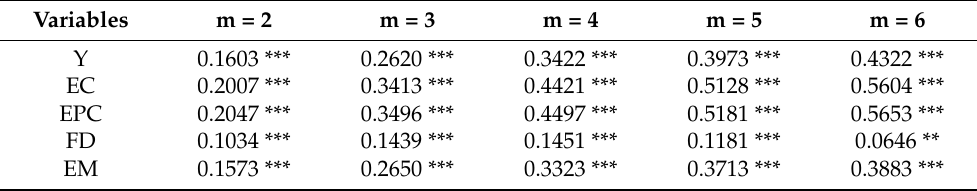
Table 5. Non-linearity